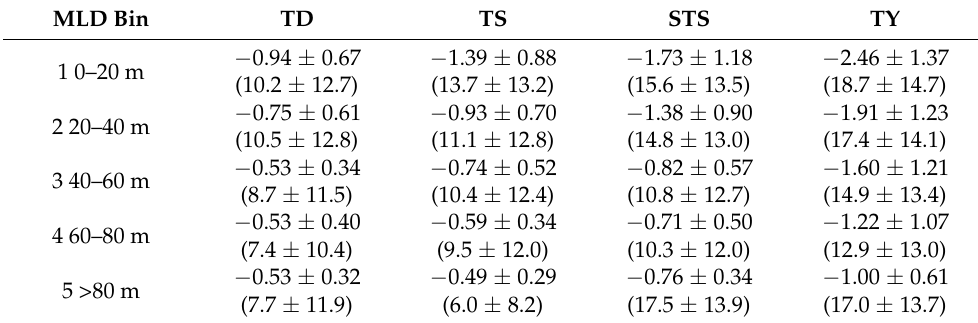
Figure 7. The average and standard deviation of maximum cooling and recovery time for each MLD bin for different ( a ) TC intensity and ( b ) translation speed (unit: m/s). The sizes of the circles in ( a ) represent the TD (smallest), TS (next to smallest), STS (next to largest), and TY (largest). The sizes of circles in ( b ) represent the translation speed of the TCs with <2.5 m/s (smallest), 2.5–5 m/s (next to smallest), 5–7.5 m/s (next to largest) and >7.5 m/s (largest). The thin and bold error bars represent the standard deviation of the individual value and the mean, respectively. The standard deviation of the mean is multiplied by 5 in the plot. Table 3. The mean maximum cooling ( ◦ C) and recovery time (days, the number in brackets) for different MLD bins for different TC intensities. TD, TS, STS, and TY represent tropical depression (MSW under 33 kn), tropical storm (MSW between 34 kn and 47 kn), severe tropical storm (MSW between 48 kn and 63 kn), and typhoon (MSW above 64 kn),